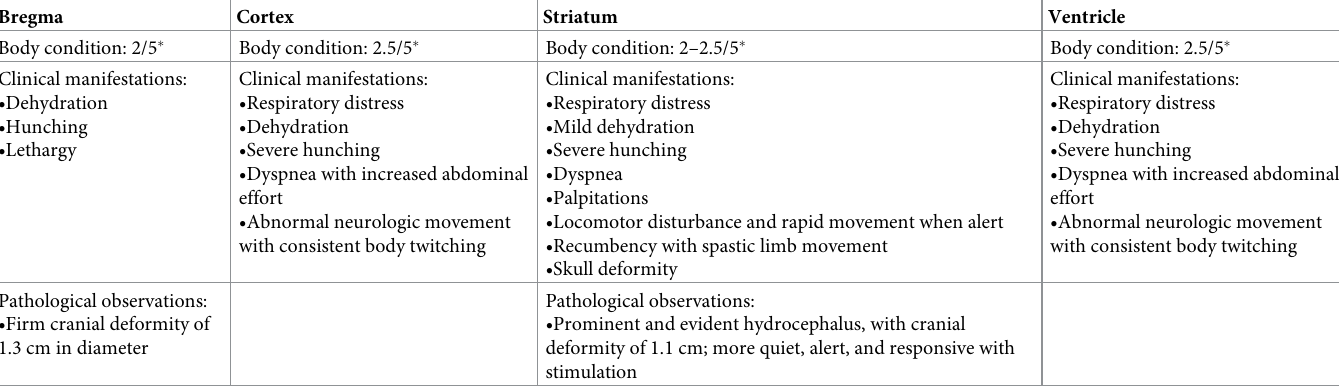
� Body Condition Scoring (BCS) Guide—a score of 2 out of 5 describes under-conditioned animal with evident segmentation of the vertebral column with readily palpable dorsal pelvic bones